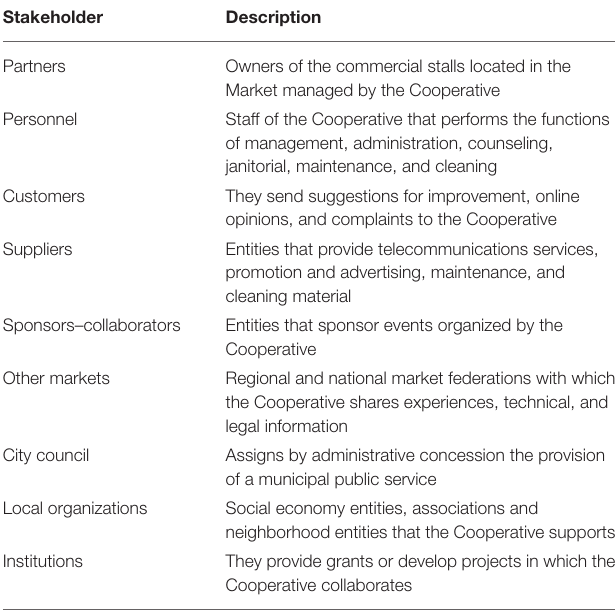
TABLE 1 | Stakeholders description and relationship with the Cooperative of the Market Nuestra Señora de